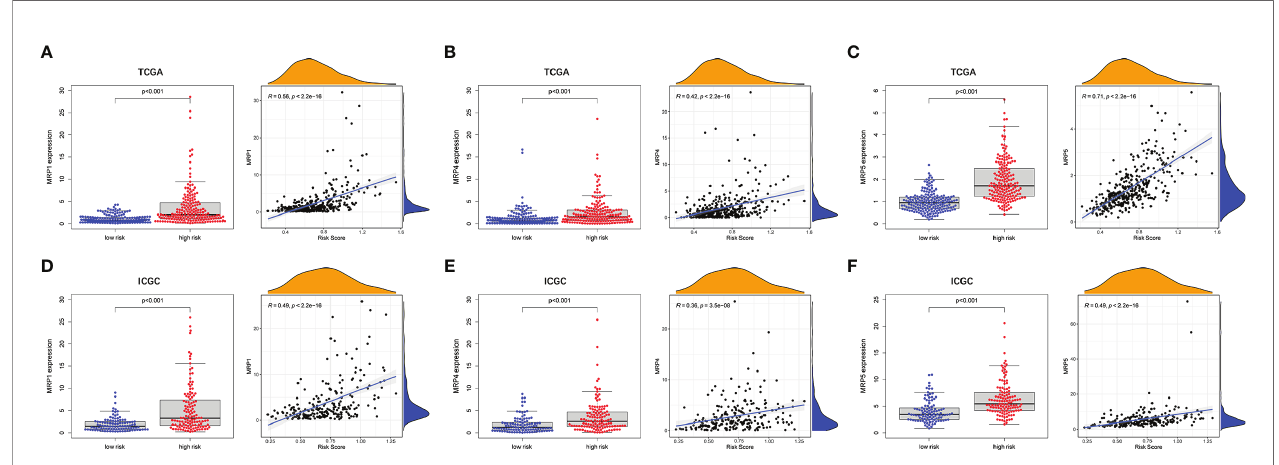
FIGURE 9 | The associations between tumor drug resistance genes and risk score. TCGA cohort (A – C) and ICGC cohort (D –